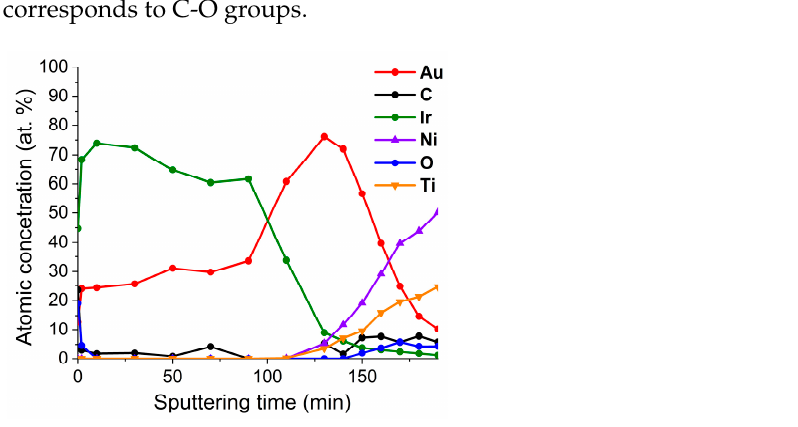
Figure 10. The XRS depth profiles of the element concentrations for the Ir/Au/TiNi sample.